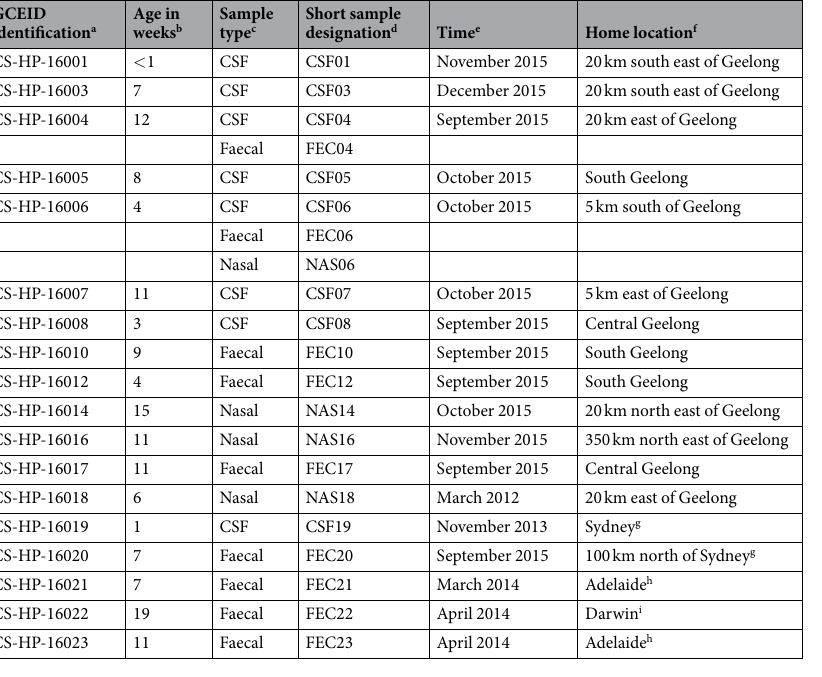
Table 1. Sample and patient information. The Table displays GCEID sample identification a , age of the affected infant when samples taken b , the sample type including cerebrospinal fluid (CSF) c , short sample designation d , time of sample taken e , and approximate home location of infant f . g Sydney is located approximately 800 km north east of Geelong. h Adelaide is located approximately 630 km north west of Geelong. i Darwin is located approximately 3100 km north of Geelong. Each of the shown cases tested positive for HPeV by reverse- transcription real-time polymerase chain reaction (rRT-PCR), conducted at the Victorian Infectious Disease Reference Laboratory (VIDRL). The Table only includes data for samples for which we had sufficient sample material to produce high quality near full-length HPeV3